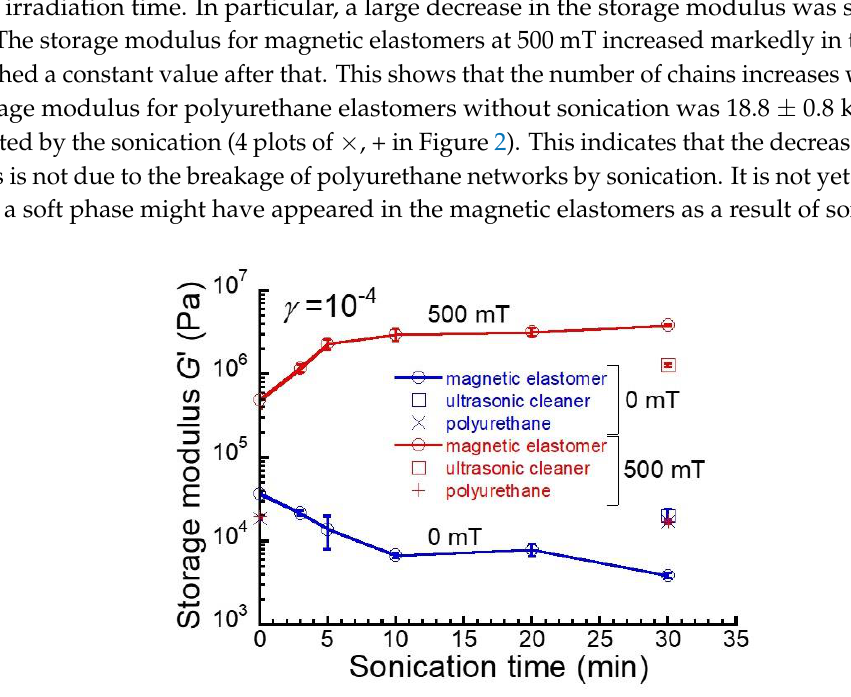
Figure 2. Relationship between storage modulus for magnetic elastomers at γ = 10 −4 and sonication time at 0 mT and 500 mT.